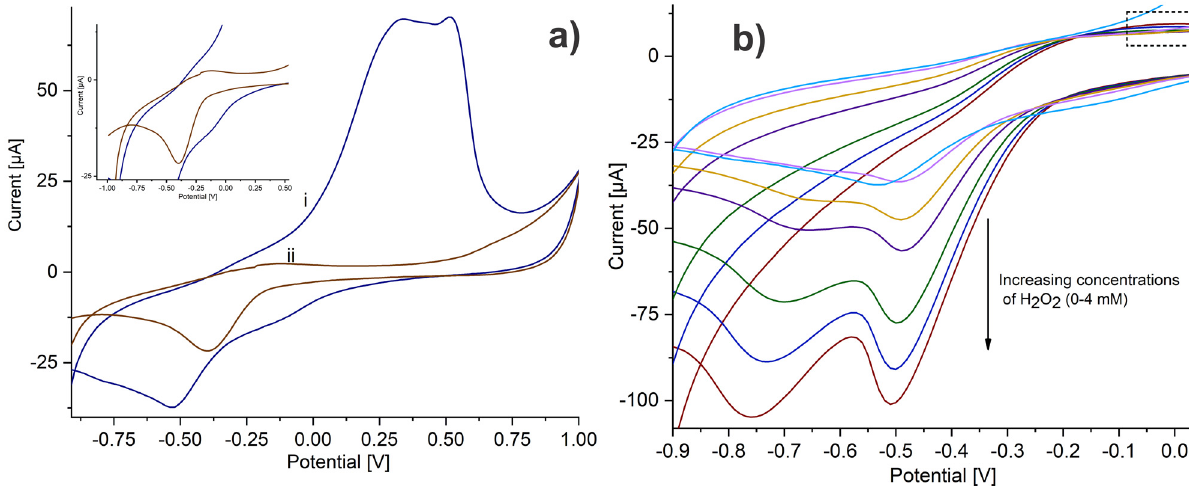
Figure 5: ( a ) Cyclic voltammetry of ( i ) SPCE/PAni/AuNP/cMWCNT/CAT and ( ii ) SPCE/AuNP/cMWCNT/CAT in PBS 0.01 M at 20 mV s − 1 . ( b ) Cyclic voltammetry for increasing concentrations of H 2 O 2 in PBS 0.01 M, recorded using the SPCE/PAni/AuNP/cMWCNT/CAT biosensor at a scan rate of 20 mV s − 1